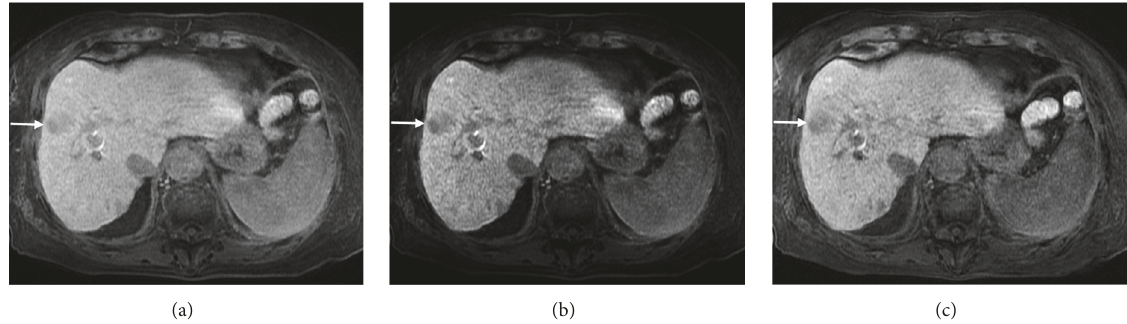
Figure 2: A low-FA original image (a), a low-FA gamma-1.8 image (b), and a high-FA image (c) in a 73-year-old woman with hepatocellular carcinoma (arrows) and liver